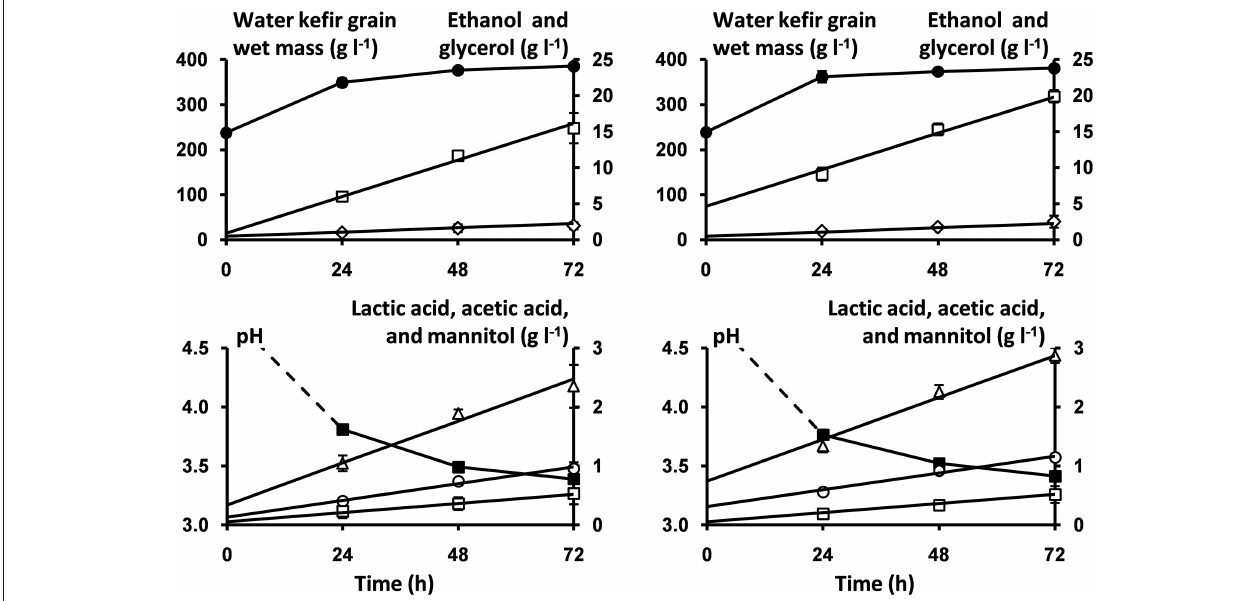
FIGURE 4 | Course of pH ( (cid:4) ) and concentrations of water kefir grain wet mass ( (cid:8) ), ethanol ( (cid:3) ), glycerol ( ♦ ), lactic acid ( 1 ), acetic acid ( (cid:13) ), and mannitol ( (cid:3) ) as a function of time, as well as the model lines (solid lines) describing the concentrations of ethanol, glycerol, lactic acid, acetic acid, and mannitol during the first 72h of fermentation of the water kefir fermentation series that started with rinsed (left) or non-rinsed (right) grains.